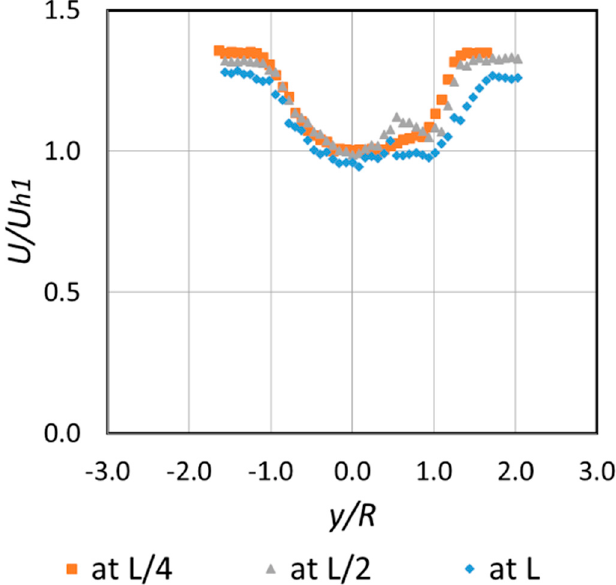
Figure 10. Configuration B: Horizontal wind speed profiles downstream of the hill.